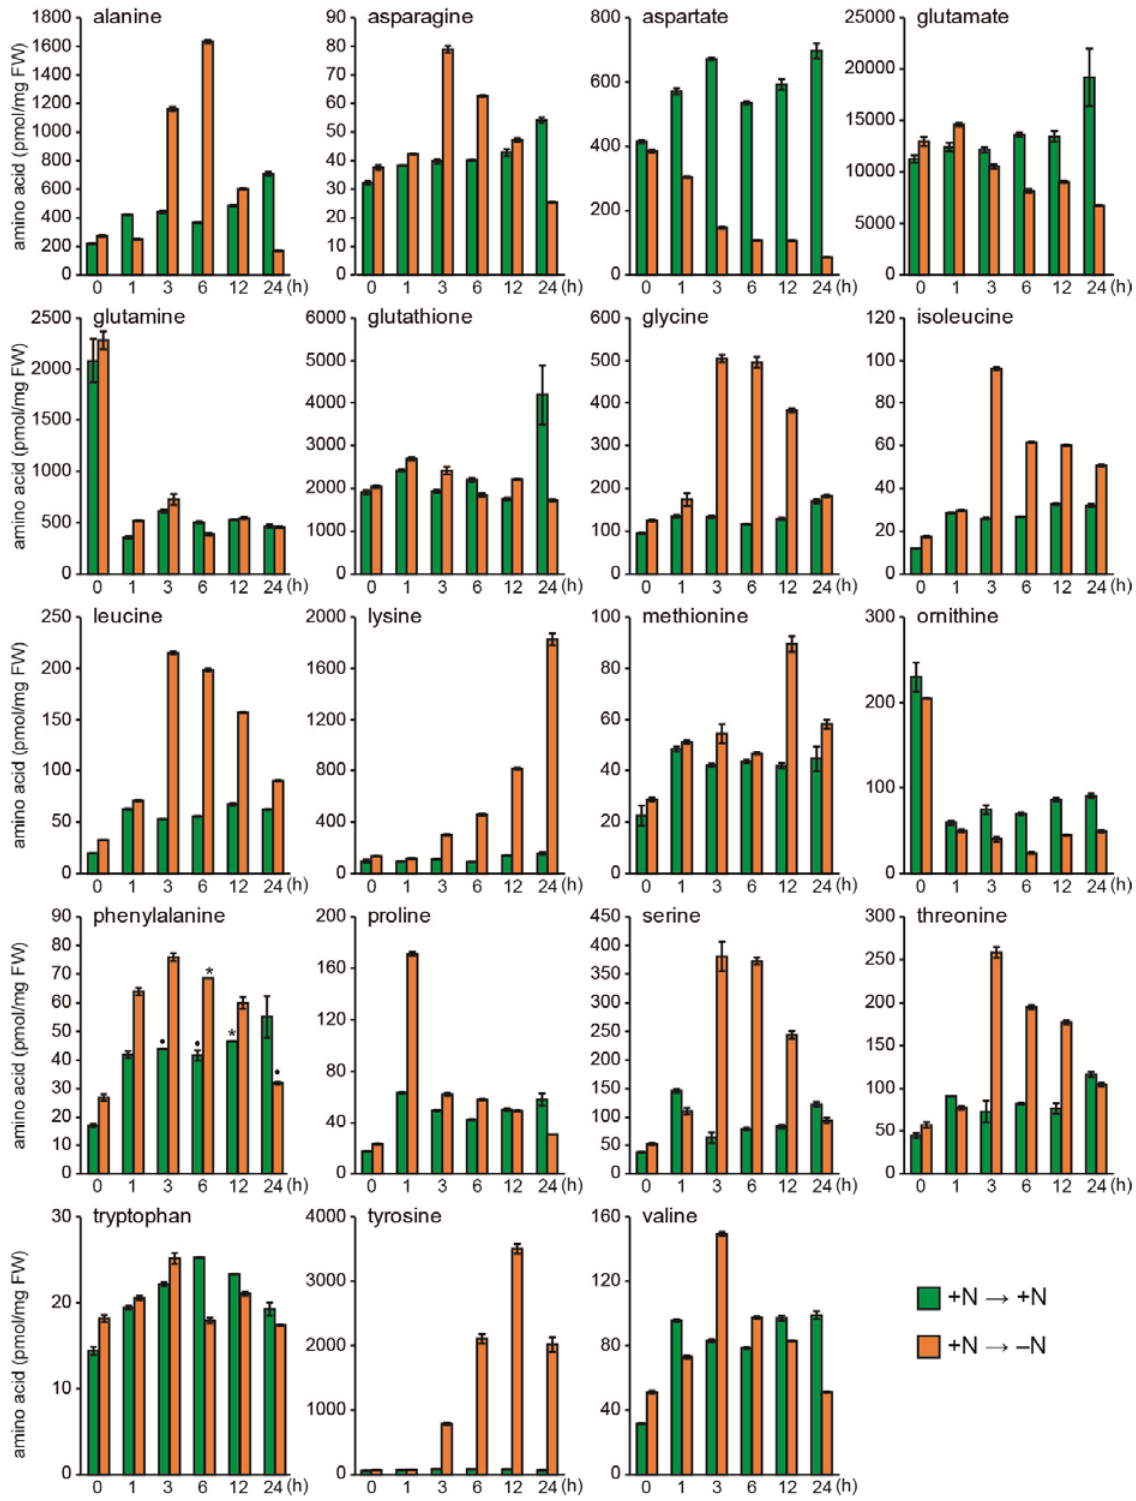
Figure 2. Changes in amino acid pools of cells during nitrogen starvation. Orange bars: cells cultured in nitrogen free medium (0 ~ 24 h), green bars: control cells cultured in the nitrate containing medium (0 ~ 24 h) after the same medium exchange treatment as the nitrogen free cells. Note that cells at 0 h were collected just after the medium exchange treatment. Standard deviation is shown from three measurements (n = 3), but asterisks and dots above bars in phenylalanine represent n = 2 and n = 1,